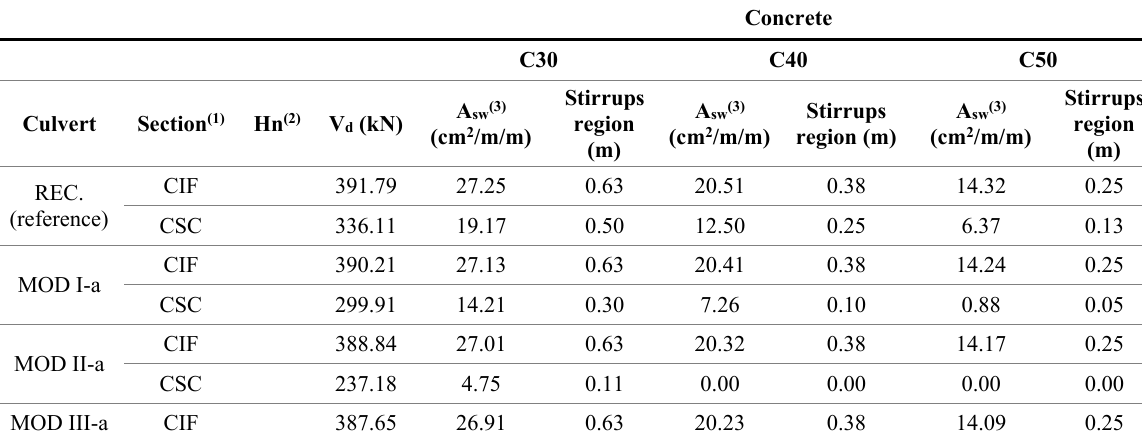
Table 6. Transverse reinforcement for critical sections CIF and CSC of the analyzed culverts.